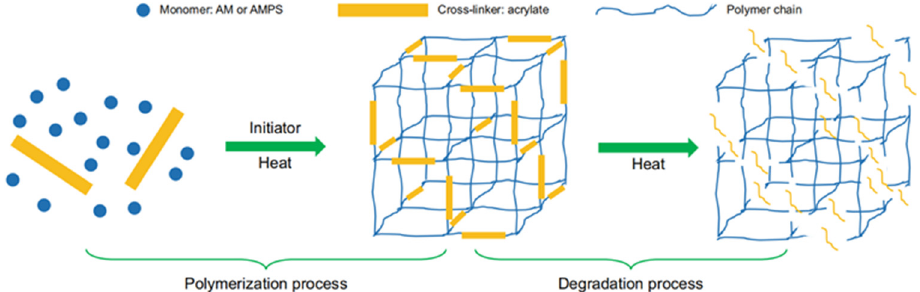
Figure 13. Degradation mechanism of DPPGs. (Reprinted/adapted with permission from Ref. [69]. 2021, Zhu et al.).